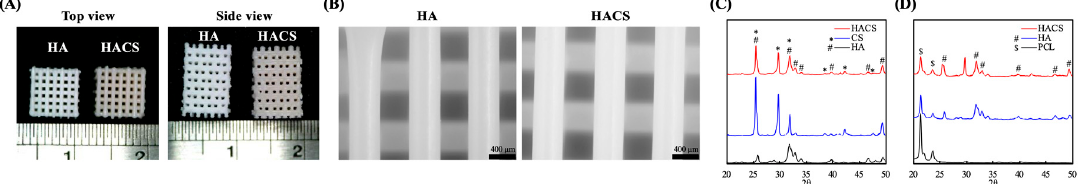
Figure 1. The photographs of ( A ) different view, ( B ) high magnification and ( C ) X-ray diffraction patterns of the hydroxyapatite (HA), calcium sulfate (CS) and HACS powder and ( D ) the 3D printed HA, HACS and PCL scaffolds.